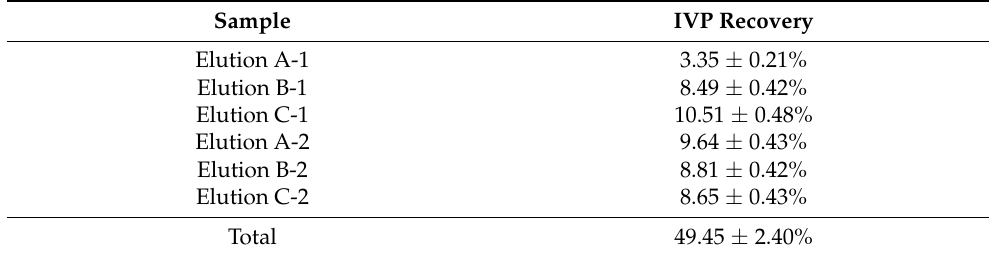
Table 1. The infectious viral particles’ recovery for each column in the continuous downstream process.